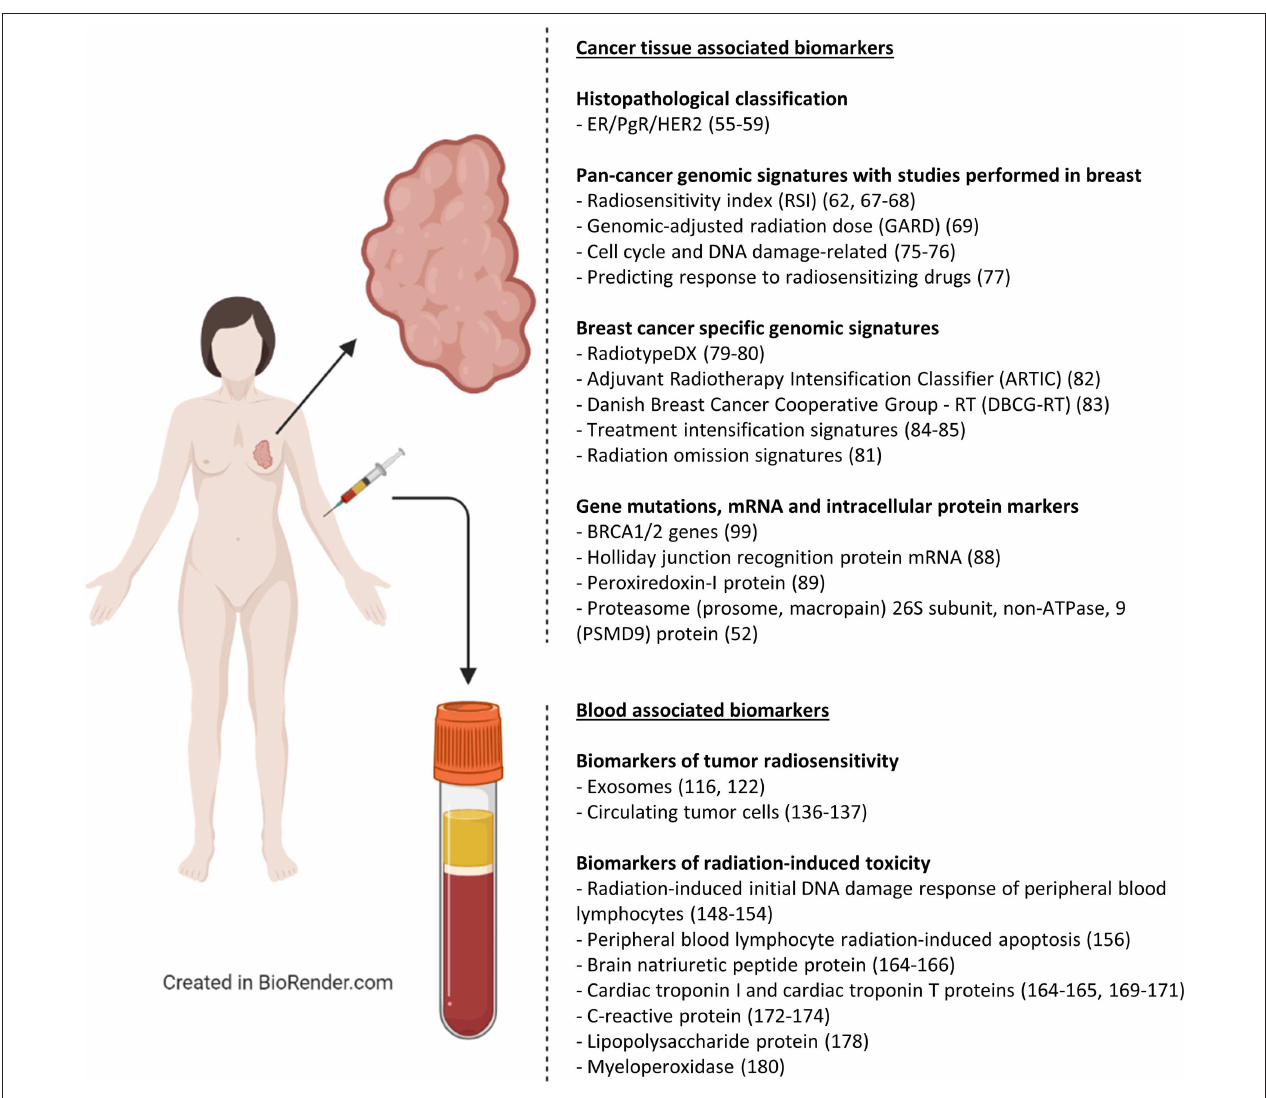
FIGURE 2 | Biomarkers of radiotherapy response for breast cancer. An overview of cancer tissue-associated and blood-associated biomarkers of radiotherapy response that have been developed for breast cancer patients (ER, Estrogen receptor; PgR, Progesterone receptor; HER2, human epidermal growth factor receptor